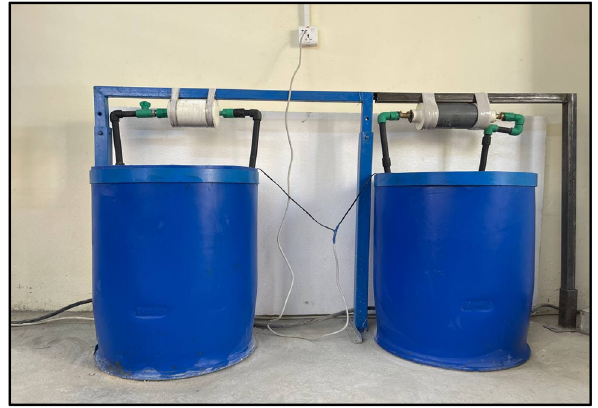
Figure 2: Experimental system of MF